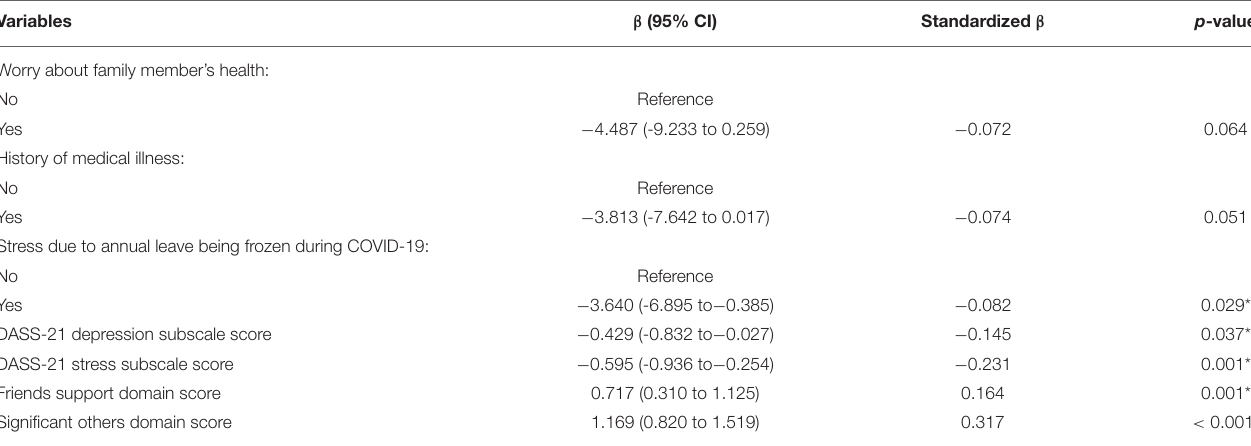
TABLE 5 | Multiple linear regression analysis with backward selection method between demographic and personal characteristics, COVID-19 related factors, psychological characteristics, perceived social support, and social relationship QoL among the respondents.